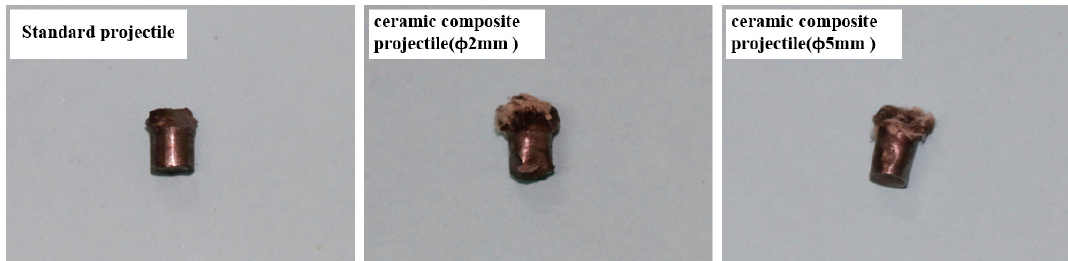
Figure 7. Recovered projectile cores after penetration of the armored steel target.